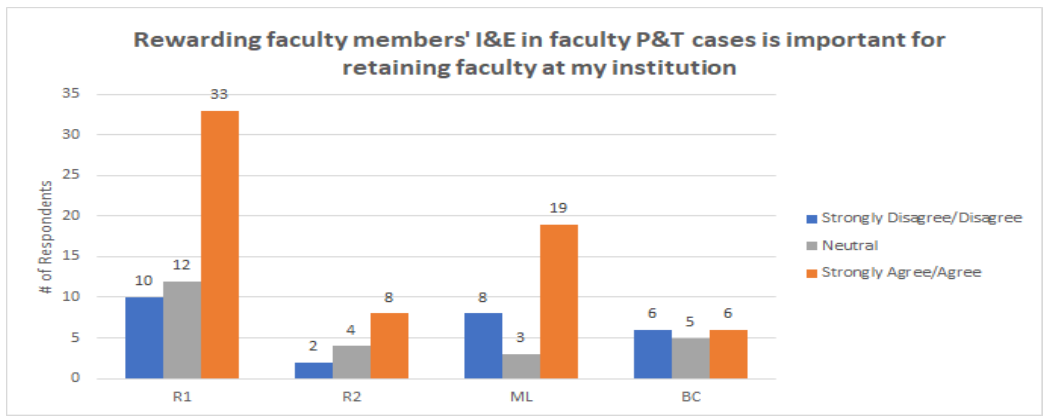
Figure 4. Comparison of institution type responses about rewarding faculty members’ I&E in P&T as important for retaining faculty at the institution.